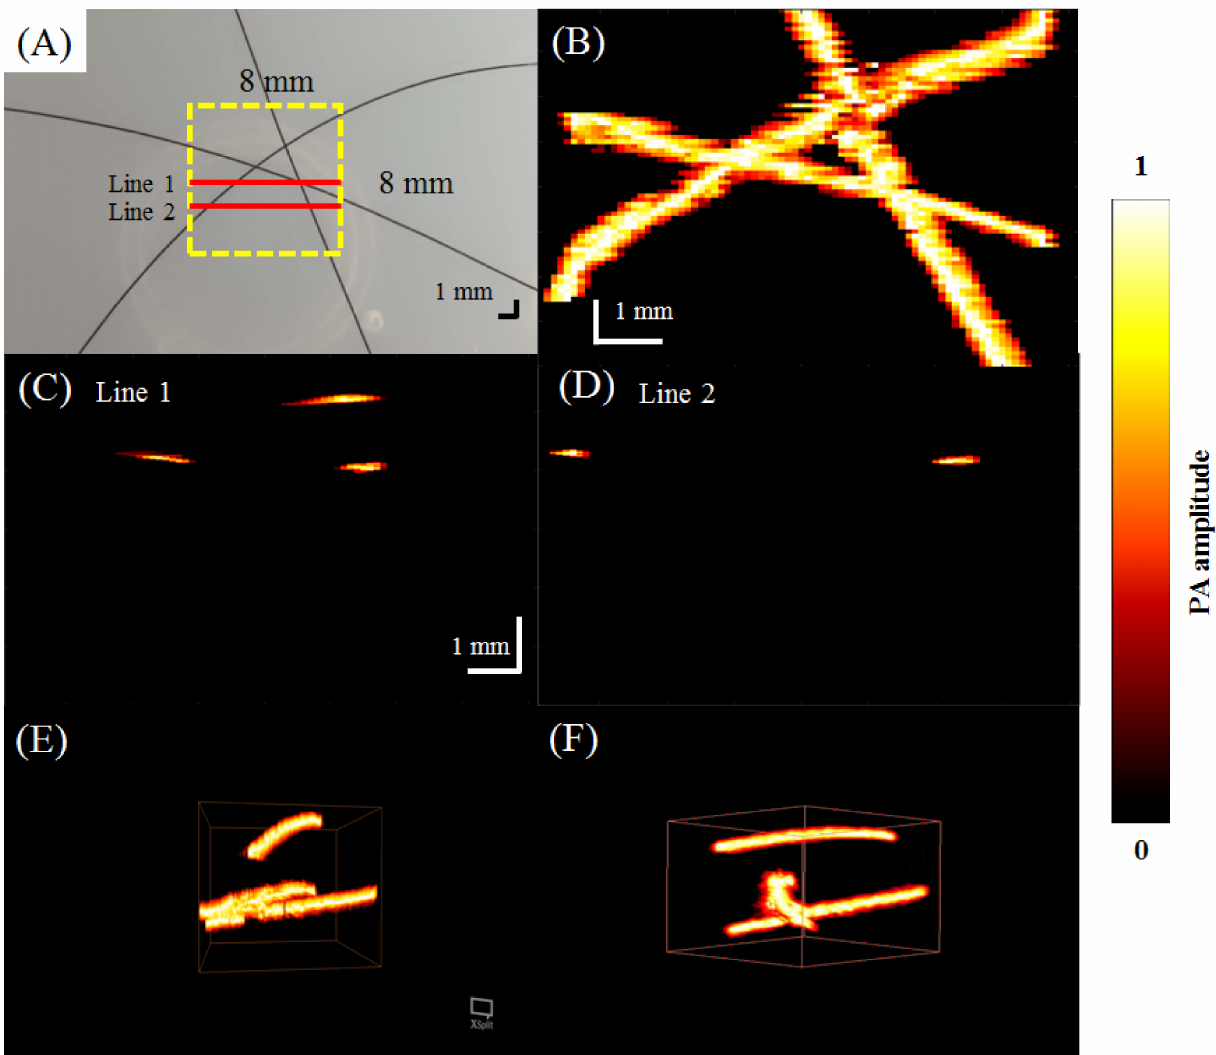
Figure 8. 3D PA images of a tissue phantom with 3 human hairs embedded obtained using a 50 MHz transducer. ( A ) Photograph of the hair phantom created for AR-PAM. ( B ) PA C-scan image. ( C , D ) PA B-scan images at red Line 1 and Line 2 indicated in ( A ). ( E , F ) 3D PA images (Videos S1 and